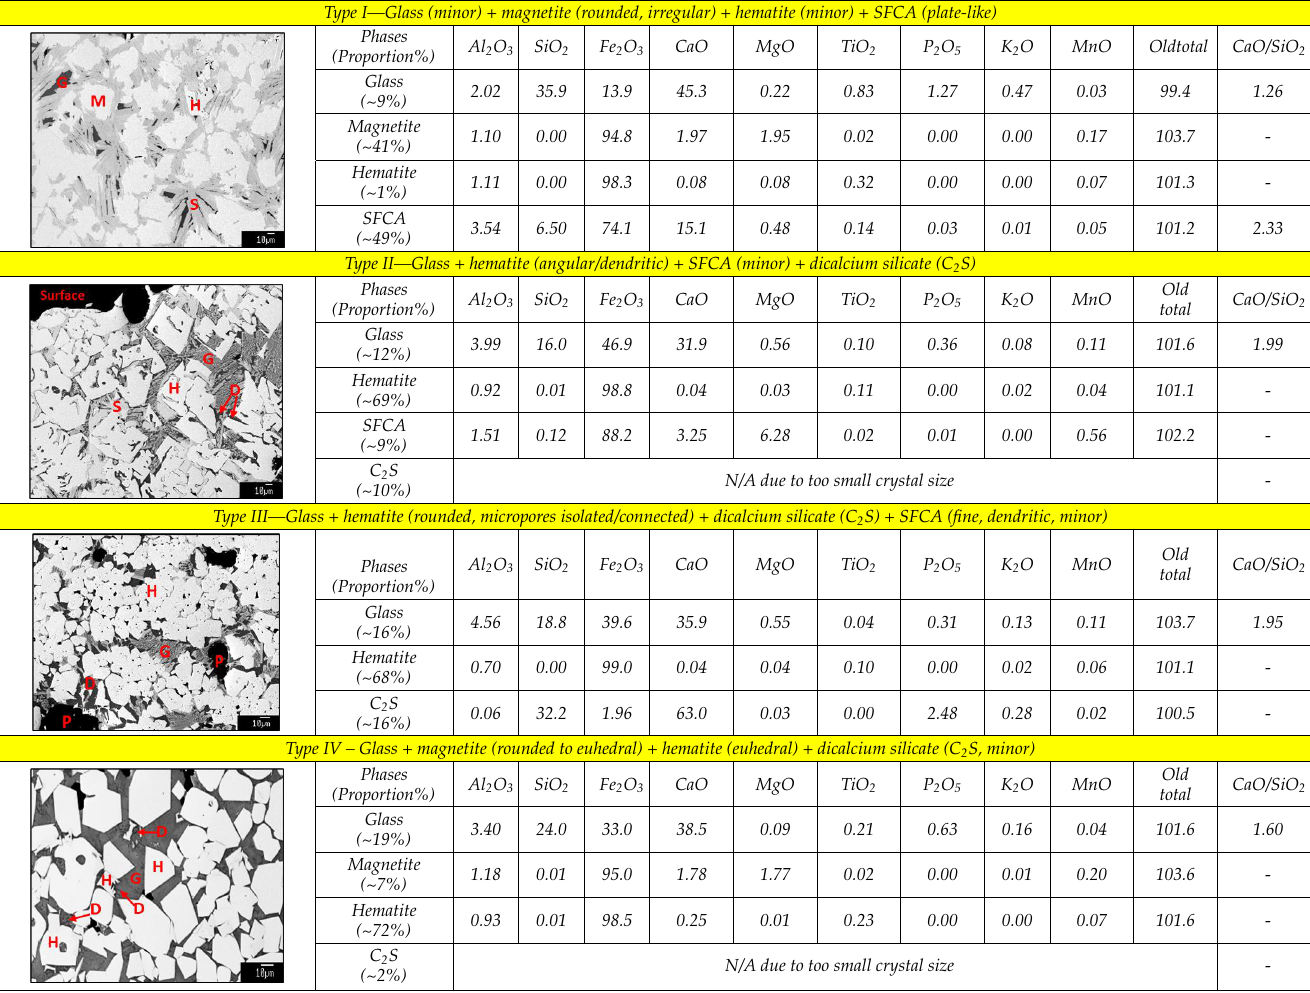
Table 3. EPMA results of phases in microstructure types I – IV in the sample (compositions in wt% and normalised to 100% for presentation purpose only). G = Glass; H = Hematite; M = Magnetite;